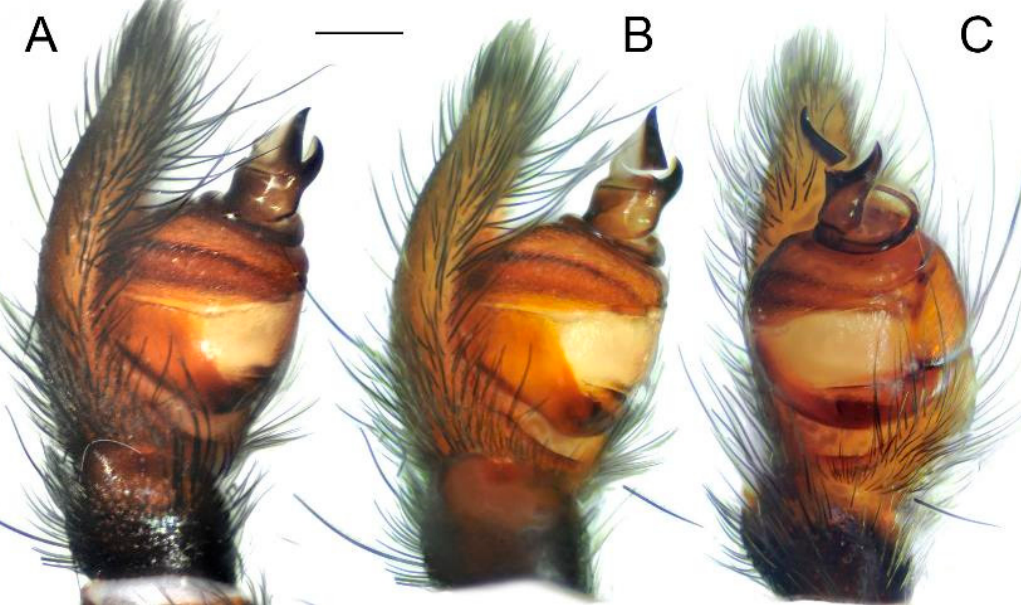
Figure 12. Holotype of Loureedia maroccana Gál et al., 2017 (damaged male palp). ( A ) Palp, before the damage, retrolateral view; ( B ) palp, after the damage (ra disconnected), retrolateral view; ( C ) palp, after the damage (ra disconnected), ventral view. Scale bar: 0.25 mm.